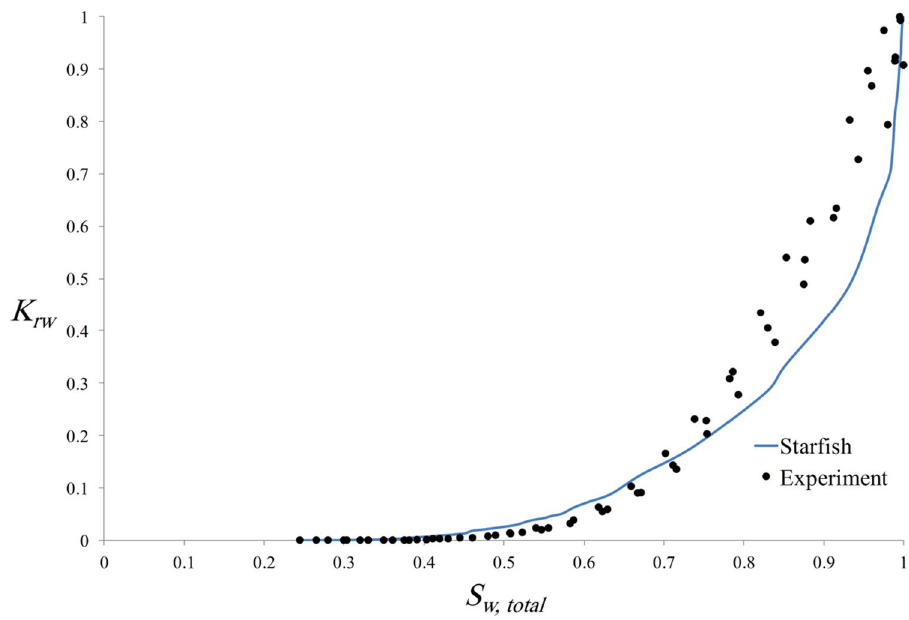
Fig. 3 Simulated and experi- mental oil relative permeability in drainage